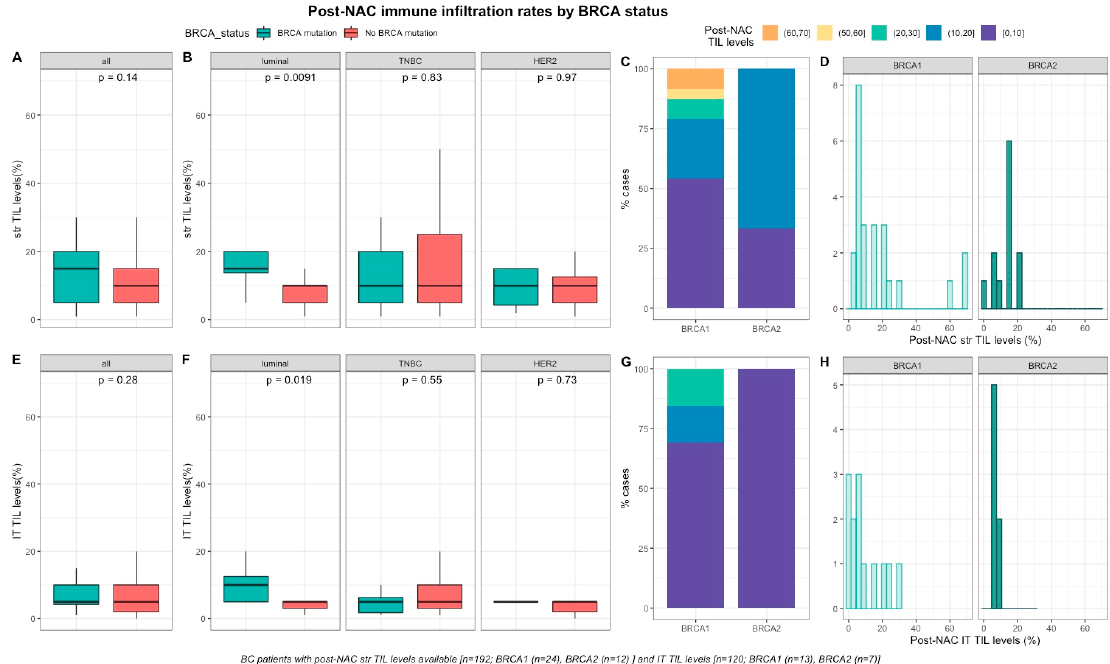
Figure 3. Associations between post-NAC TILs and BRCA status in whole population, and after stratification by breast cancer subtype. Bottom and top bars of the boxplots represent the first and Table 1. 5 times the interquartile range. ( A ) stromal lymphocytes among the whole population (All ( n = 192), BRCA mutation ( n = 36), BRCA wild-type ( n = 156)). ( B ) stromal lymphocytes in each BC subtype (Luminal ( n = 52), BRCA mutation ( n = 8), BRCA wild-type ( n = 44); TNBC ( n = 97), BRCA mutation ( n = 24), BRCA wild-type ( n = 73); HER2 ( n = 43), BRCA mutation ( n = 4), BRCA wild-type ( n = 39)). ( C ) Percentage of tumor according to post-NAC stromal lymphocytes levels binned by 10% increment in patients with BRCA -deficient ( BRCA 1 ( n = 24), BRCA 2 ( n = 12)). ( D ) distribution of post-NAC stromal lymphocytes by gene mutations (histogram plot) in patients with BRCA -deficient ( BRCA 1 ( n = 24), BRCA 2 ( n = 12)). ( E ) intratumoral lymphocytes among the whole population (All ( n = 120), BRCA mutation ( n = 20), BRCA wild type ( n = 100)). ( F ) intratumoral lymphocytes in each BC subtype (Luminal ( n = 44), BRCA mutation ( n = 7), BRCA wild-type ( n = 37); TNBC ( n = 50), BRCA mutation ( n = 12), BRCA wild-type ( n = 38); HER2 ( n = 26), BRCA mutation ( n = 1), BRCA wild-type ( n = 25)). ( G ) percentage of tumor according to post-NAC intratumoral lymphocytes levels binned by 10% increment in patients with BRCA -deficient ( BRCA 1 ( n = 13), BRCA 2 ( n = 7)). ( H ) distribution of post-NAC intratumoral lymphocytes by gene mutations (histogram plot) in patients with BRCA -deficient ( BRCA 1 ( n = 13), BRCA 2 ( n = 7)). Median pre-NAC str TIL were higher than after NAC (20% vs. 10%, 11.95%), also according to